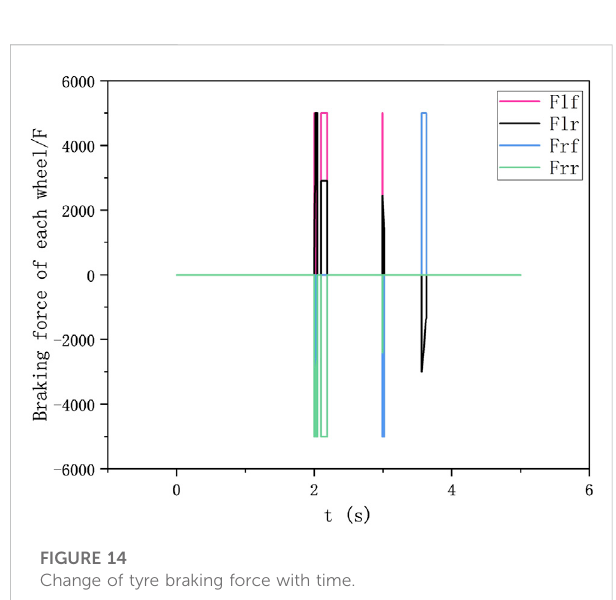
FIGURE 15 Trajectory